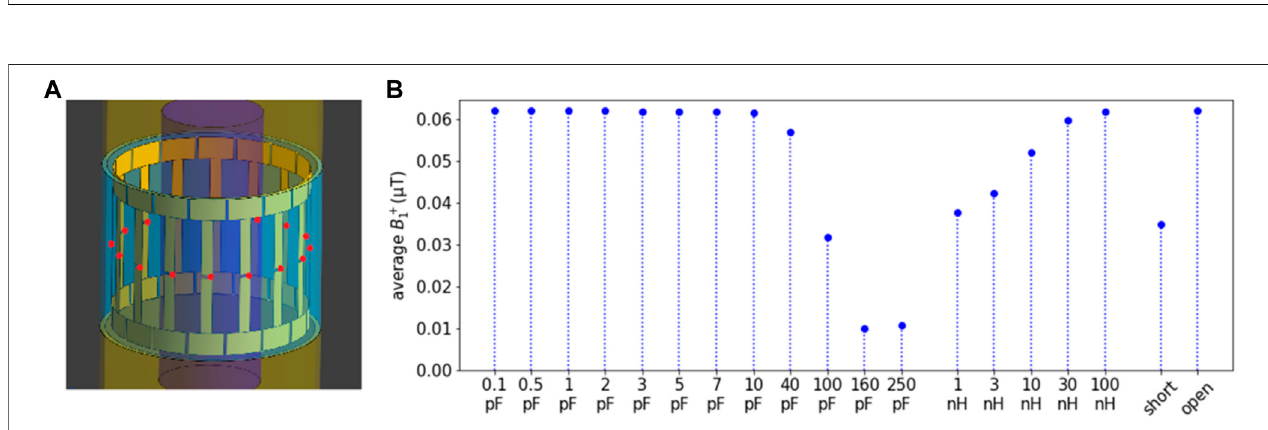
1 map obtained with